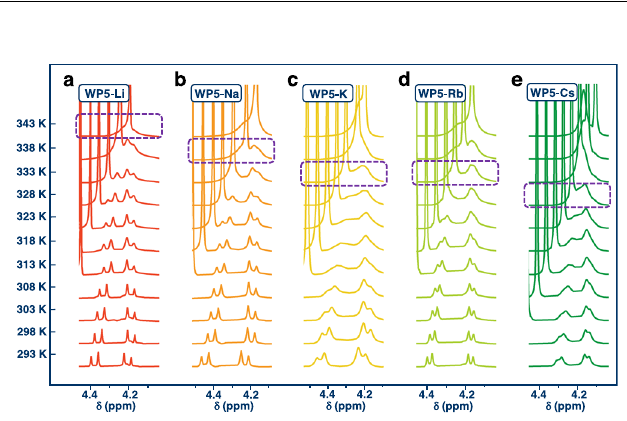
Fig. 3 | Partial VT NMR spectra of WP5-M in D 2 O. The coalesce temperature for WP5-Li ( a ), WP5-Na ( b ), WP5-K ( c ), WP5-Rb ( d ), and WP5-Cs ( e ) was 343K, 338K, 333K, 333K, and 328K, respectively (marked with purple dashed). The con- centration of rotors was 10.0mM.